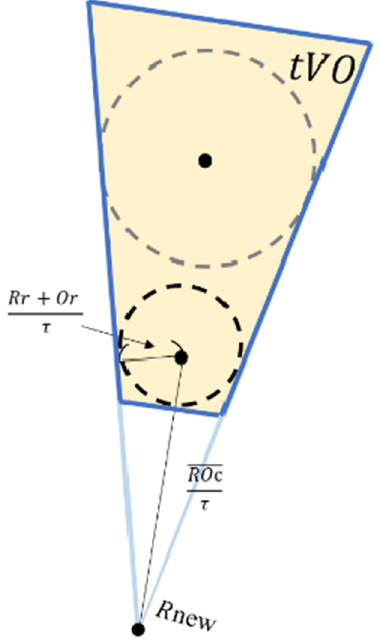
Figure 9. Truncate velocity obstacles.